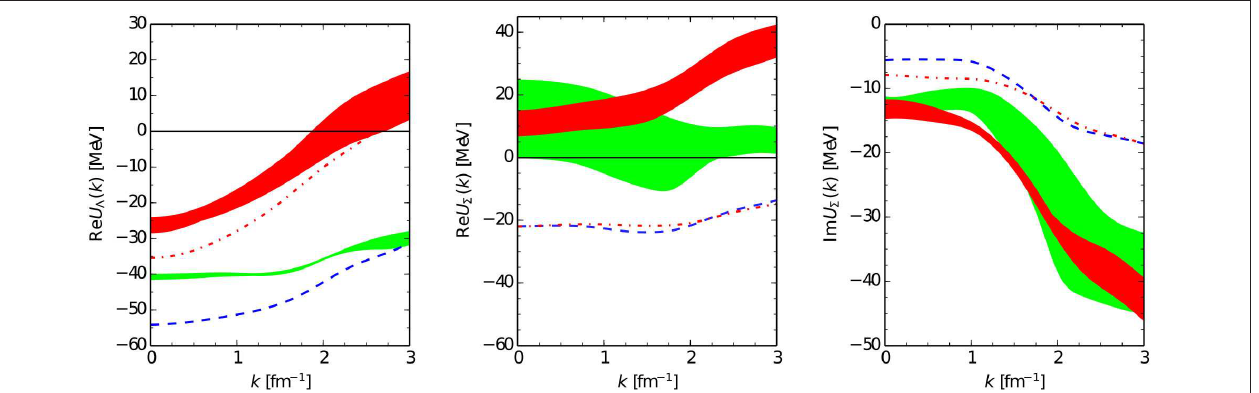
FIGURE 17 | Momentum dependence of the real part of the single-particle potential of a 3 hyperon and of the real and imaginary parts of the single-particle potential of a 6 hyperon in isospin-symmetric nuclear matter at saturation density, k F 1.35 fm − 1 [76]. The red band, green band, blue dashed curve, and red dash-dotted = curve are for χ EFT NLO, χ EFT LO, the Jülich ’04 model and the NSC97f model, respectively.